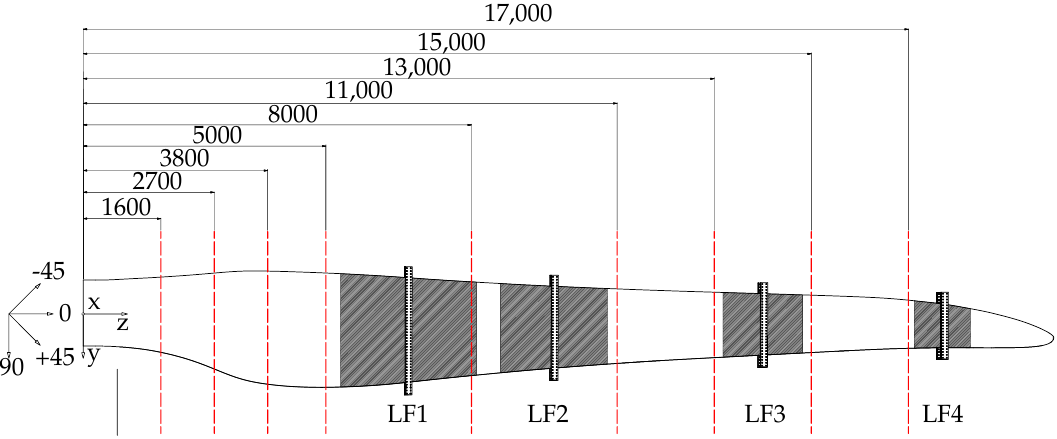
Figure 2. Top view of positions of strain gauges and definition of the load frames (LF 1–4) [8].